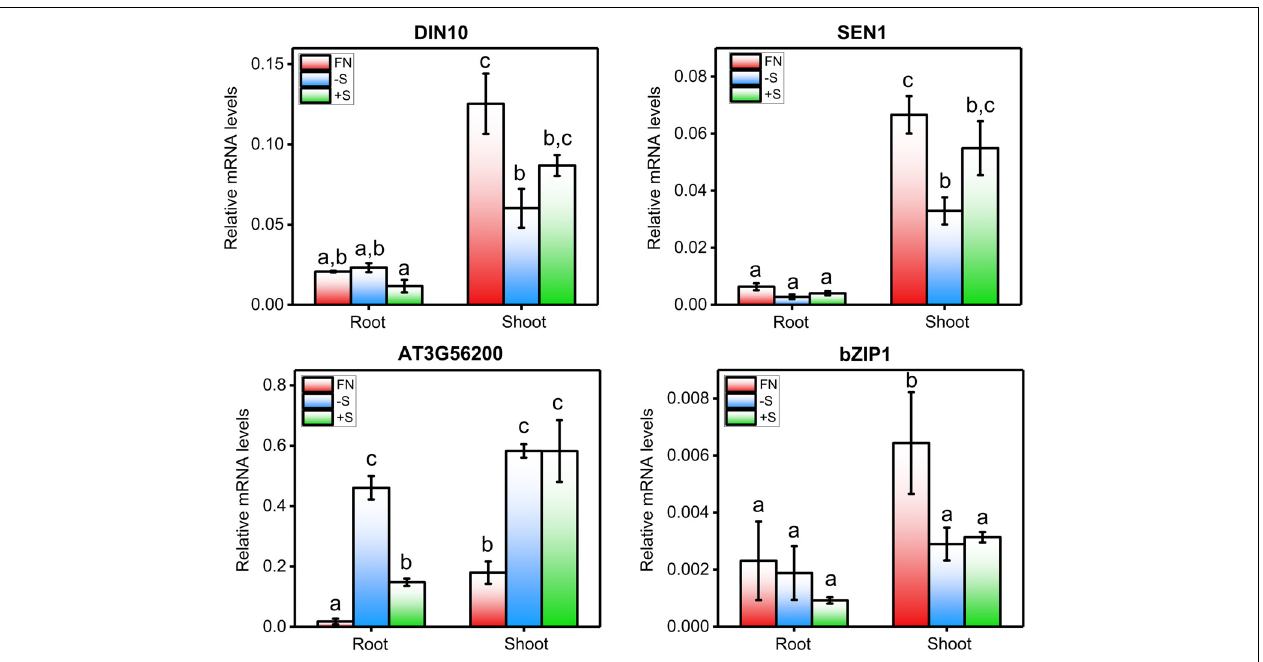
FIGURE 6 | qPCR-analyzed expression profiles of hub genes identified in the sulfate co-expression network. The mRNA levels of DIN10 , SEN1 , AT3G56200, and bZIP1 were determined by qPCR in three different samples: FN (full nutrient-treated samples), +S (sulfate-treated samples) and –S (sulfate-starved samples). For more details regarding this experiment, see the legend in Figure 2 . The values plotted correspond to the means of three independent experiments ± standard errors of the mean; 80 to 100 seedlings were used per replicate. The means with different lowercase letters are significantly different, p < 0.05 (one-way ANOVA and Tukey’s